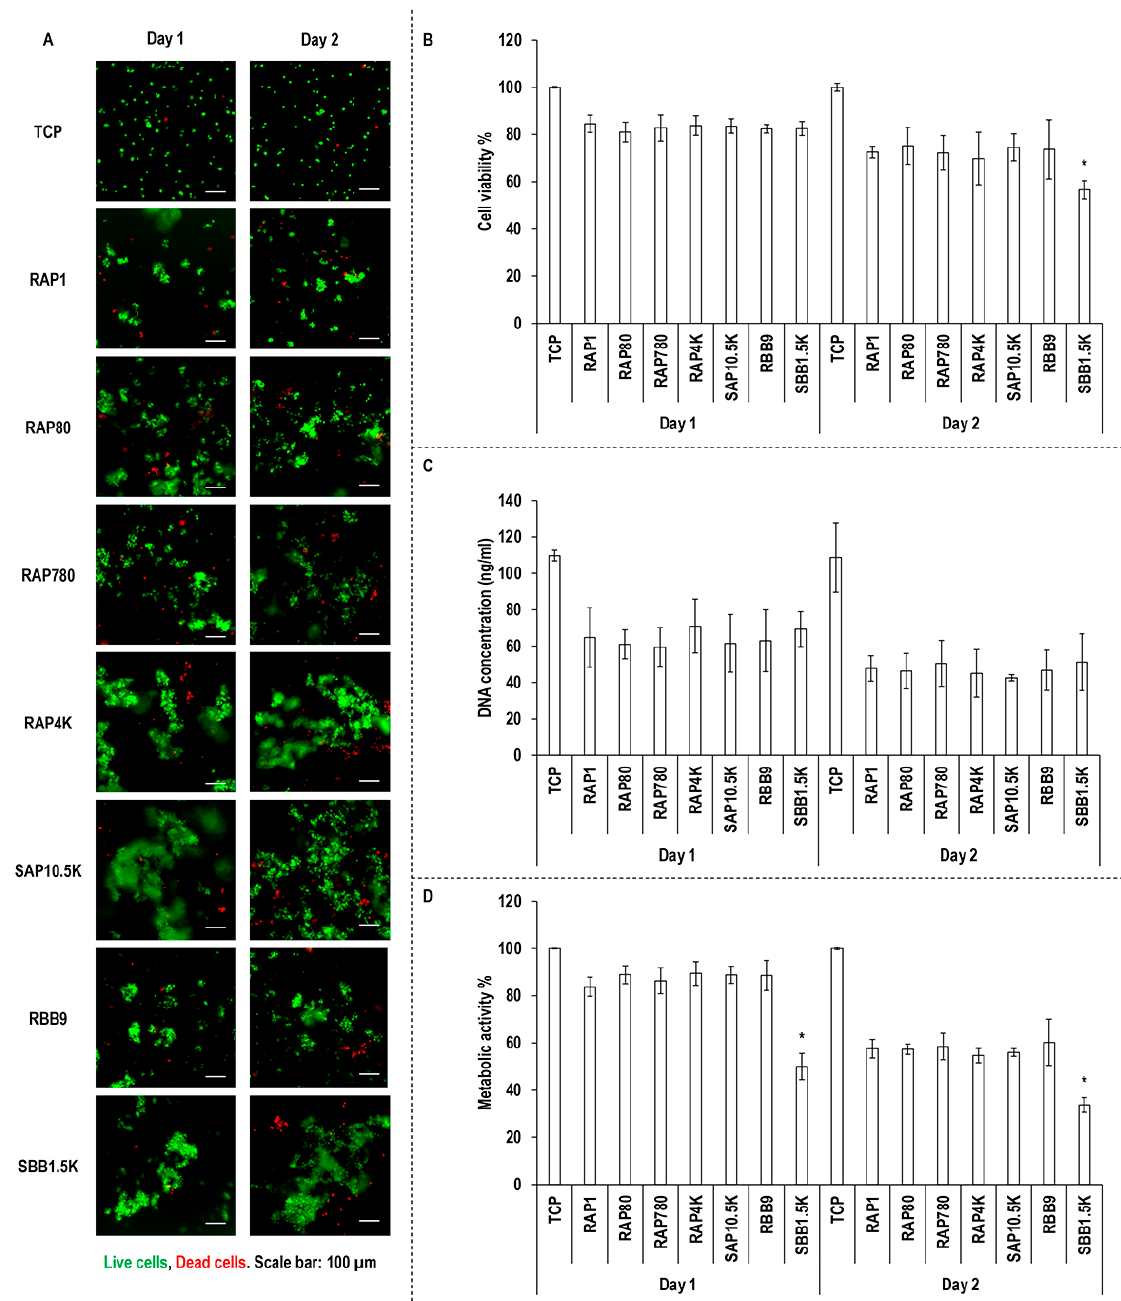
Figure 3. Macrophage viability ( A , B ), DNA concentration ( C ) and metabolic activity ( D ) analyses. *: Indicates statistically significant difference ( p < 0.05) between the gelatin samples used in this study at a given timepoint.